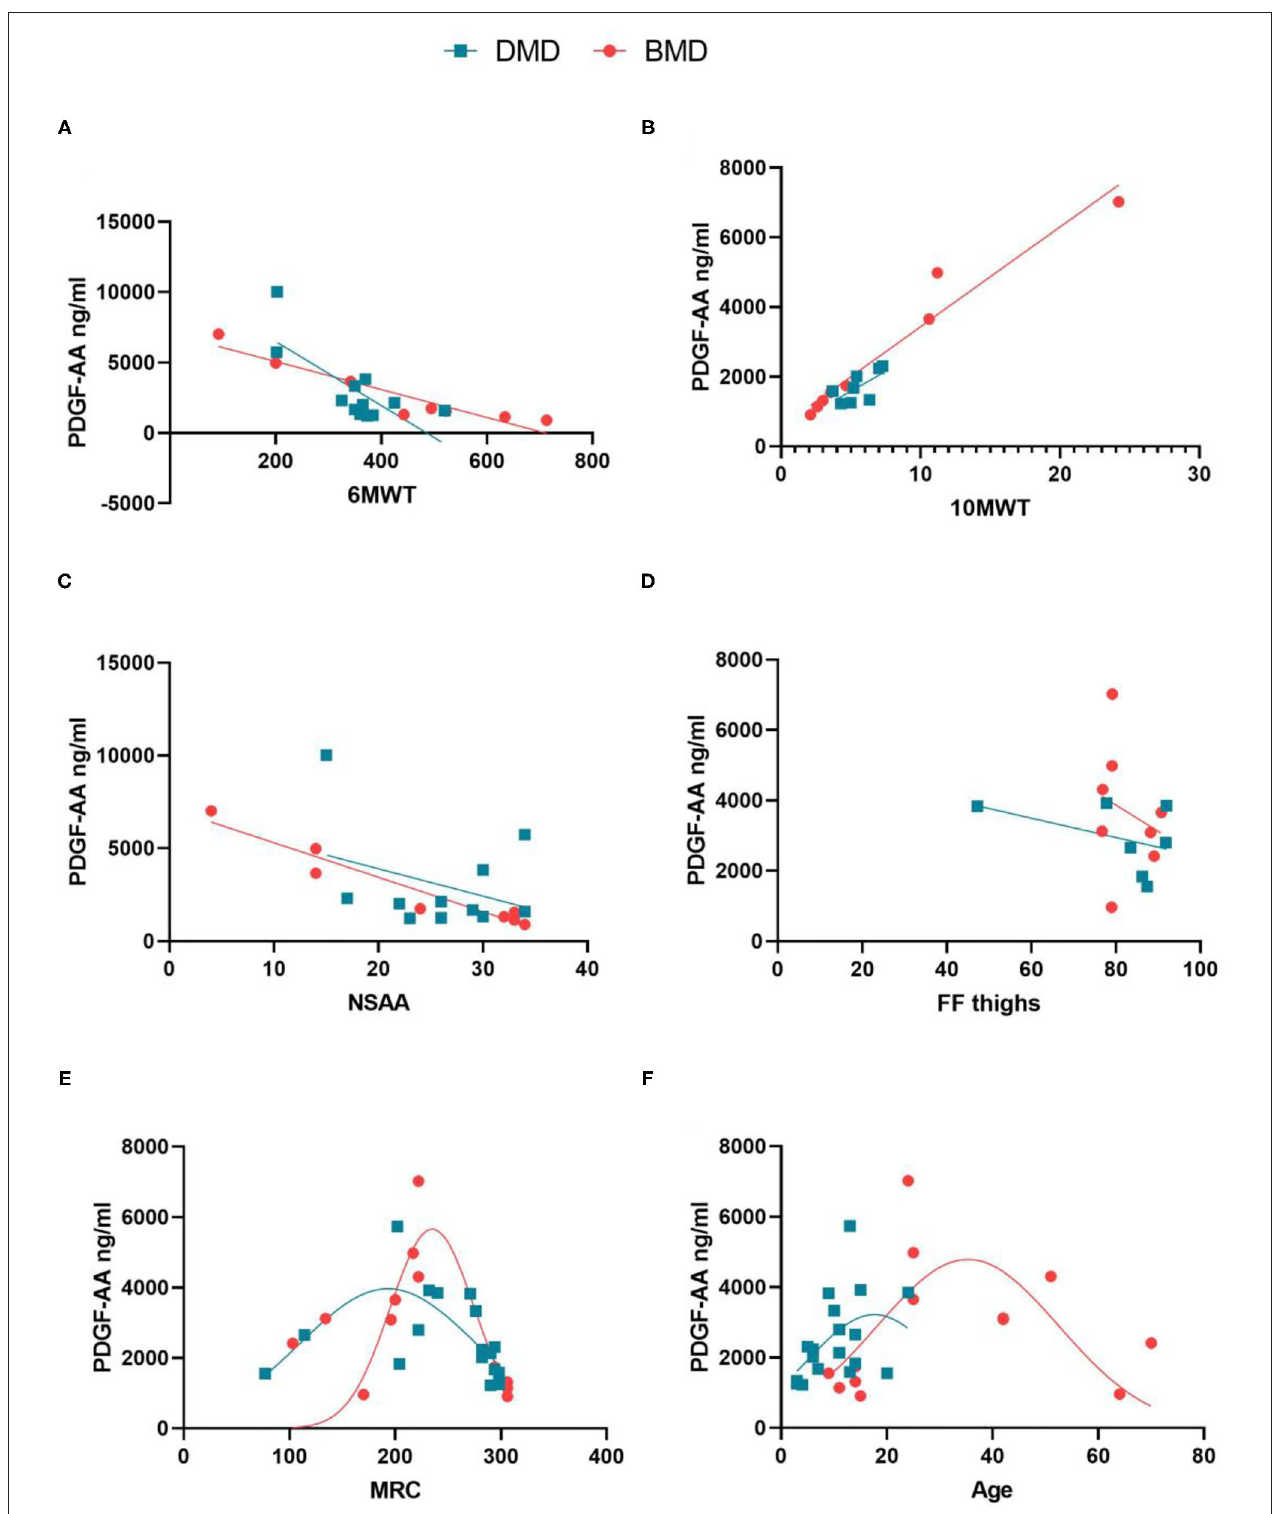
FIGURE 2 | Correlation between PDGF-AA levels and different muscle tests in patients with DMD and BMD. (A) Correlation between PDGF-AA and the results of the 6MWT; (B) Correlation between PDGF-AA 10 MWT; (C) Correlation between PDGF-AA and results of the NSAA scale; (D) Correlation between PDGF-AA and thigh fat fraction; (E) Distribution of PDGF-AA serum levels depending on the muscle strength quantified using MRC score; (F) distribution of PDGF-AA serum levels depending on the age of the patients. Spearman test was performed, R, Correlation coefficient; p, statistical significance. Red lines: BMD patients; blue lines: DMD patients.